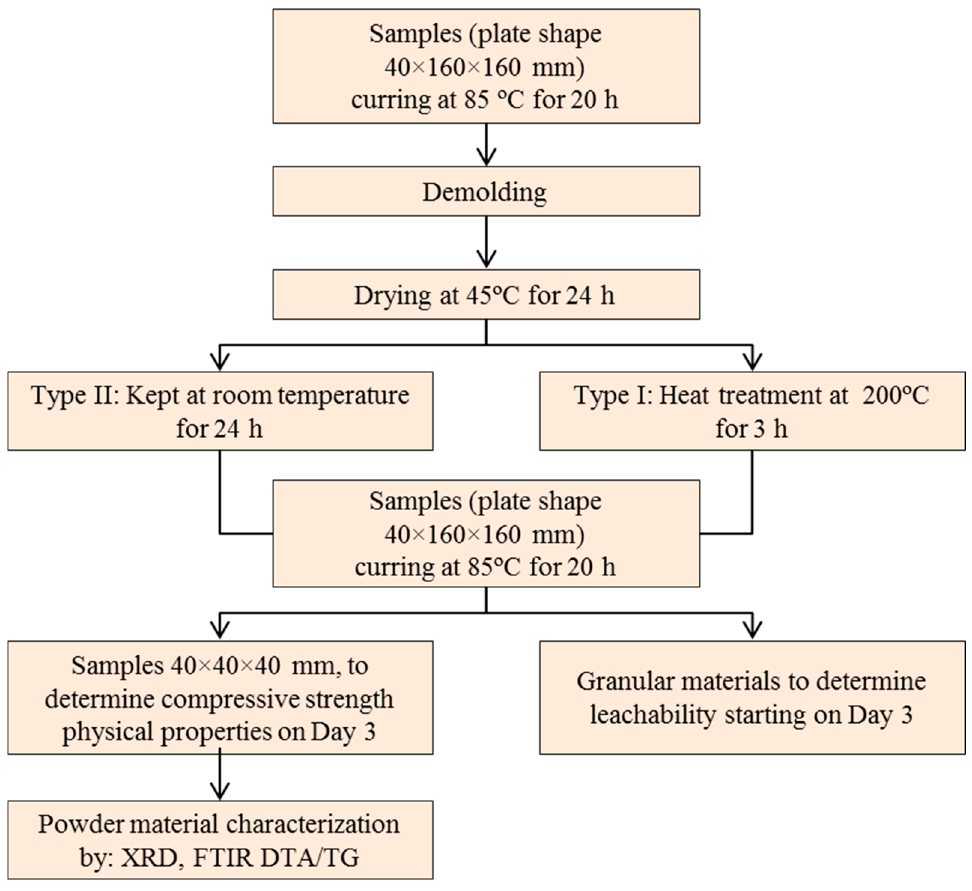
Figure 1. Scheme of sample testing.